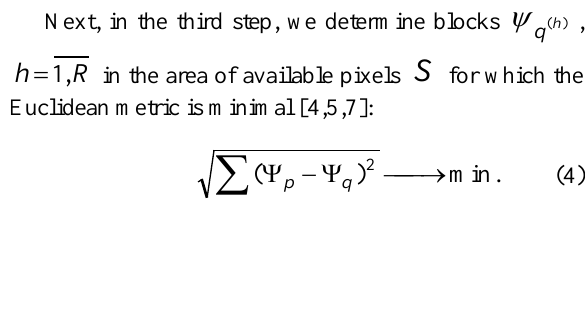
Fig. 4. Example of splitting an image into